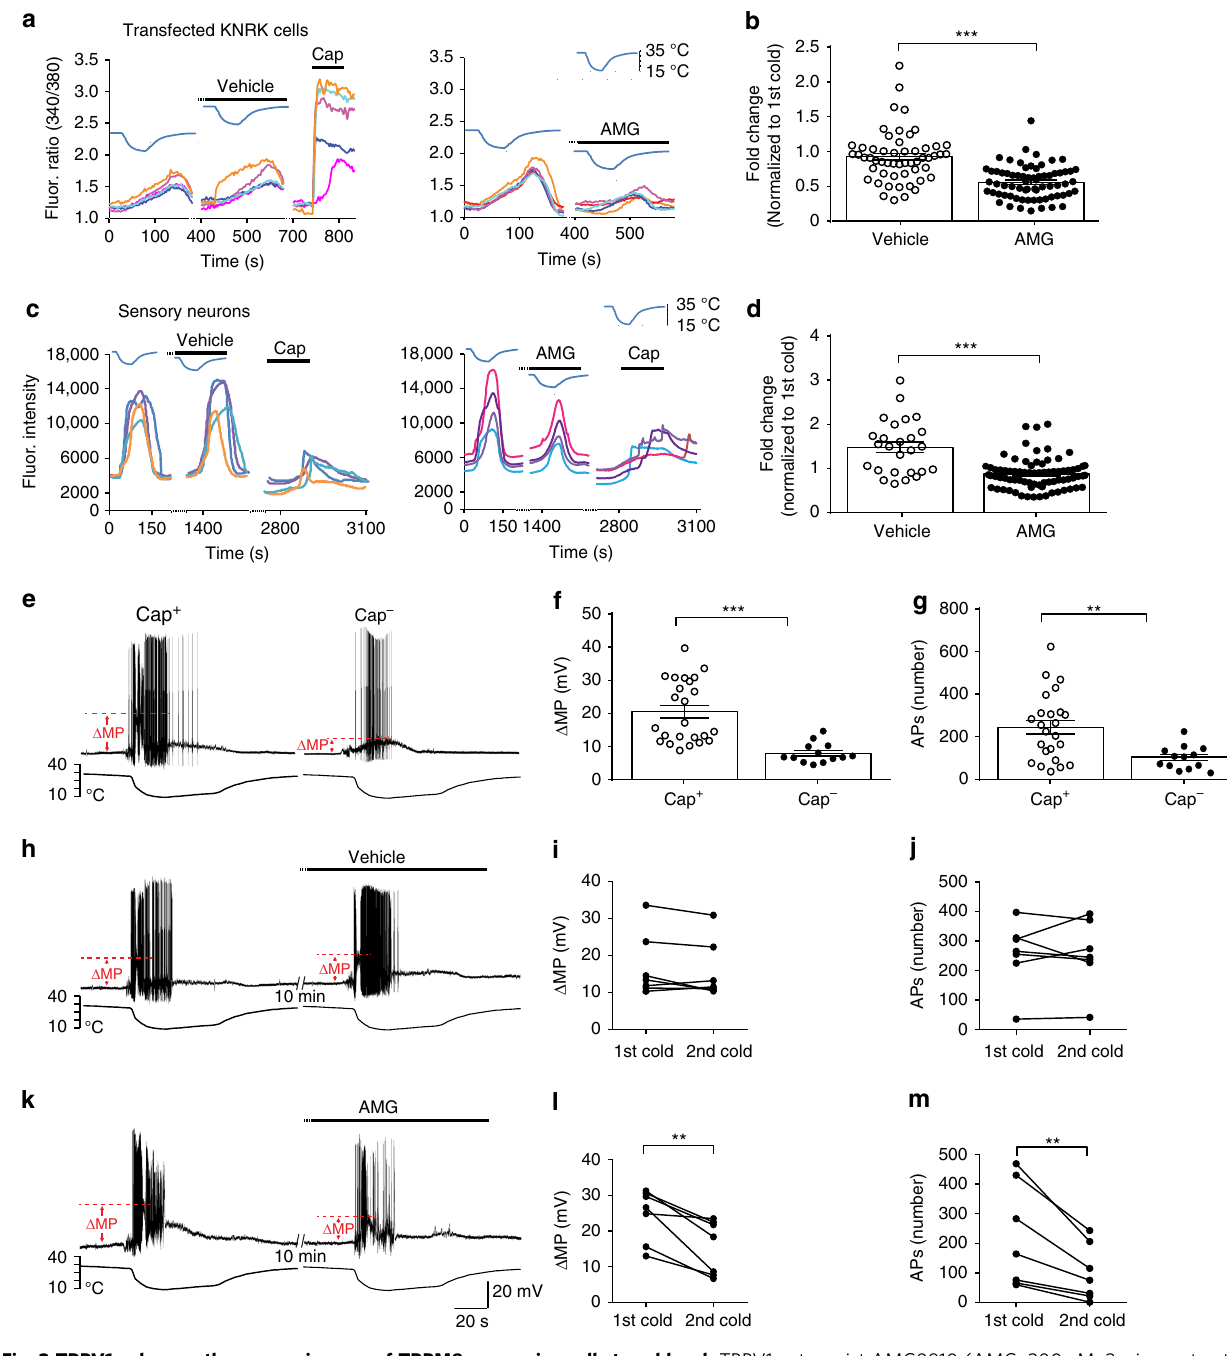
Fig. 3 TRPV1 enhances the responsiveness of TRPM8-expressing cells to cold. a , b TRPV1 antagonist AMG9810 (AMG, 300 nM, 3 min pre-treatment before cold stimulation) attenuated calcium responses to cold in transfected KNRK cells that co-express TRPM8 and TRPV1. As a control, the vehicle treatment did not change their response to cold or capsaicin (Cap, 1 µ M). Cold stimulation was generated by bath temperature drop from 32 °C to 15 °C. Each dot in b represents a KNRK cell that co-expresses TRPM8 and TRPV1. c Representative calcium transients of sensory neurons to cold stimuli after 10 min pre-treatment of vehicle (0.0006% DMSO in calcium imaging buffer) or AMG9810 (300 nM). Imaged neurons were located within the cornea- projection area in the ophthalmic division of the whole trigeminal ganglion explants ( n = 7) from Pirt GCaMP3/ + transgenic mice, in which a calcium indicator GCaMP3 was expressed in primary sensory neurons. The expression of TRPV1 in tested neurons was determined by their responses to capsaicin (10 µ M). d Quanti fi cation of calcium responses of trigeminal neurons to cold. Each dot represents one cold-sensing neuron. e – g Cold treatments elicited greater membrane potential changes ( Δ MP) and more action potentials (APs) in a subset of TRPM8 EGFPf/ + sensory neurons that are sensitive to capsaicin (1 µ M, identi fi ed by calcium imaging) than those insensitive to capsaicin. h – j Repeated cold treatments did not desensitize TRPM8 EGFPf/ + ; TRPV1 + sensory neurons in the vehicle control group, as shown by stable membrane potential changes and neuronal fi ring. k – m Application of TRPV1 antagonist AMG9810 (300 nM, 10 min pre-treatment before cold stimulation) effectively suppressed depolarization and neuronal fi ring in capsaicin-sensitive TRPM8 EGFPf/ + neurons upon subsequent cold treatment. Data are expressed as mean ± s.e.m. Statistical analysis by two tailed Student ’ s t -test. ** P < 0.01; *** P < 0.001. Source data are provided as a Source Data fi